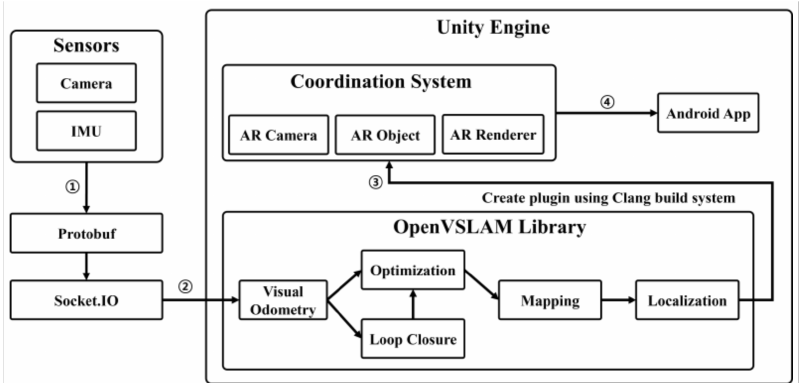
Figure 4. Mobile SLAM system architecture for stand-alone